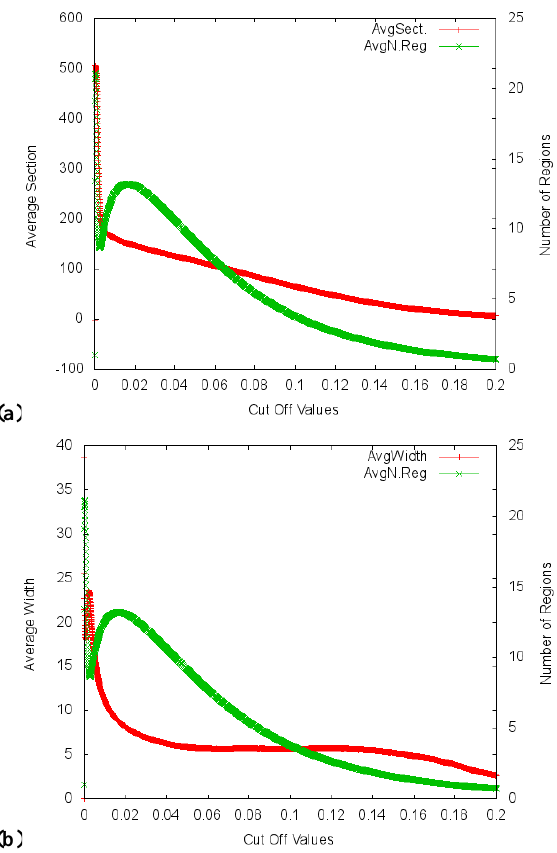
Fig. 5. (a) shows the width of the layer containing all the bins above the cutoff value of the magnetic field gradient averaged over the whole simulation box “average section”. (b) shows the average width of each separate contiguous region above the